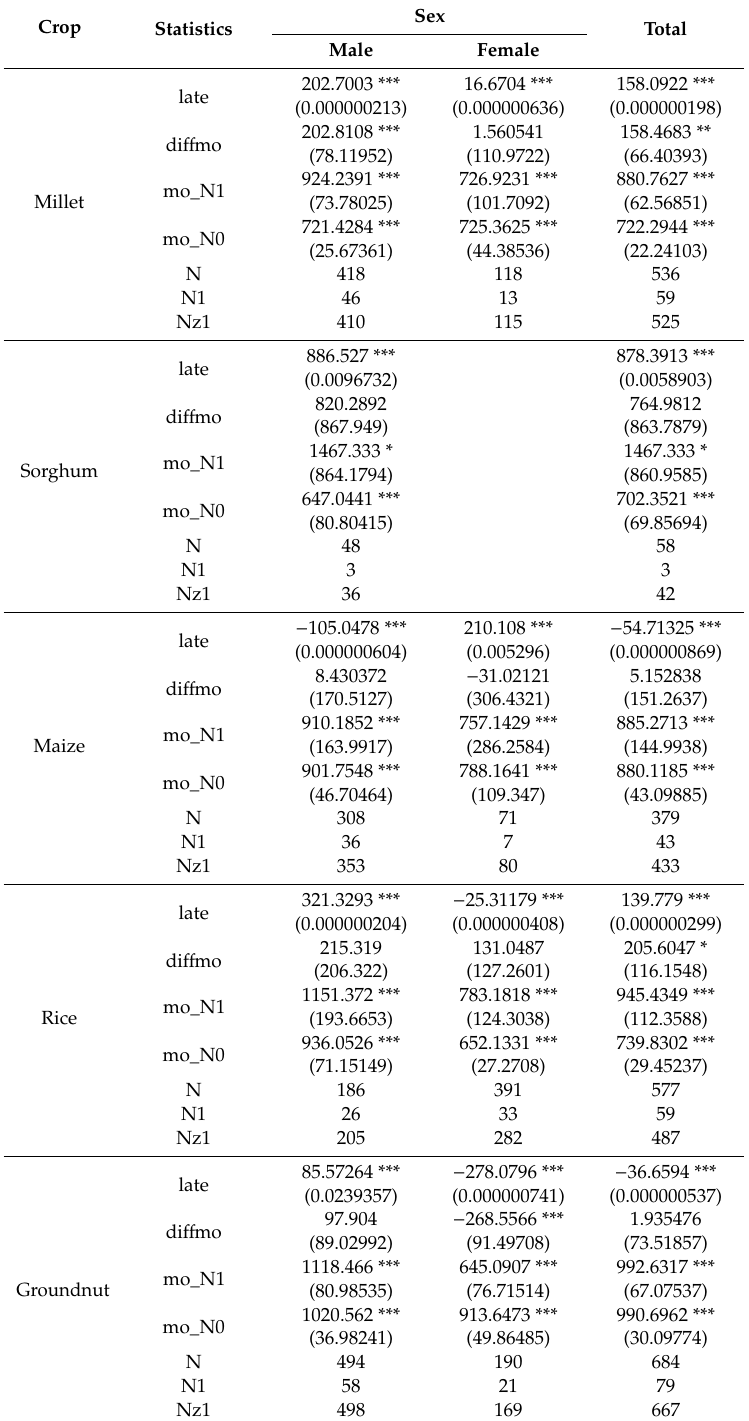
Table 9. Impact of the use of SF on the main